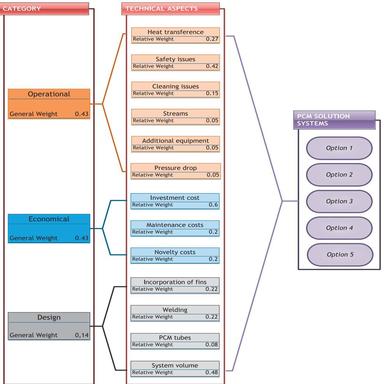
Hierarchical structure for the technical aspects included in the main categories, with their general and relative weights, for the evaluation of the PCM-TES alternative solutions.